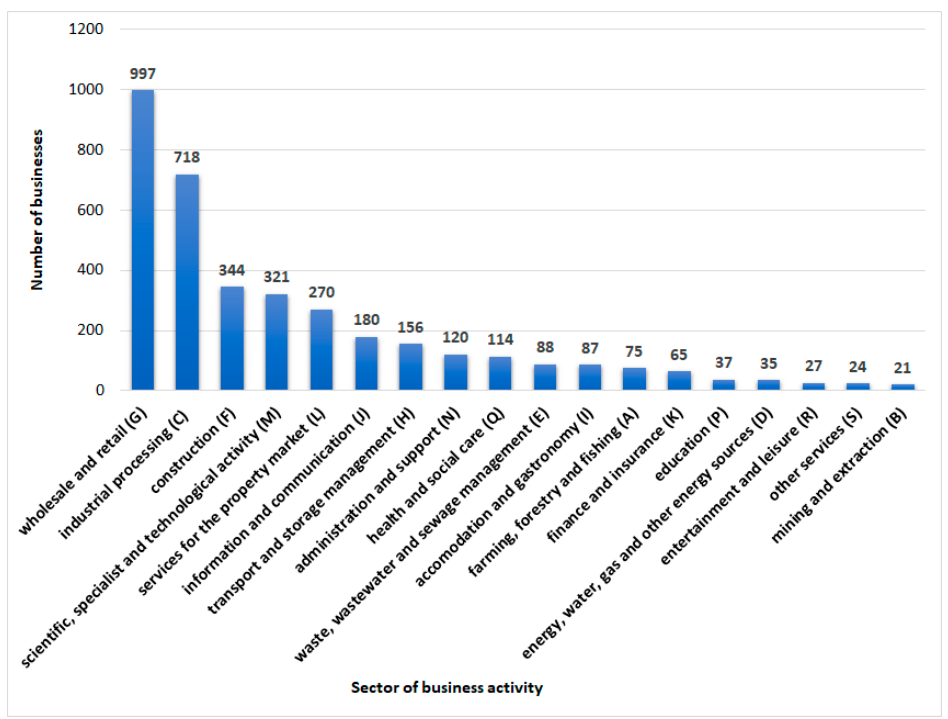
Figure 3. Businesses in the Podkarpackie Voivodeship by sector of activity. Source: own elaboration based on the data analyzed from 2018 (http://www.emis.com).